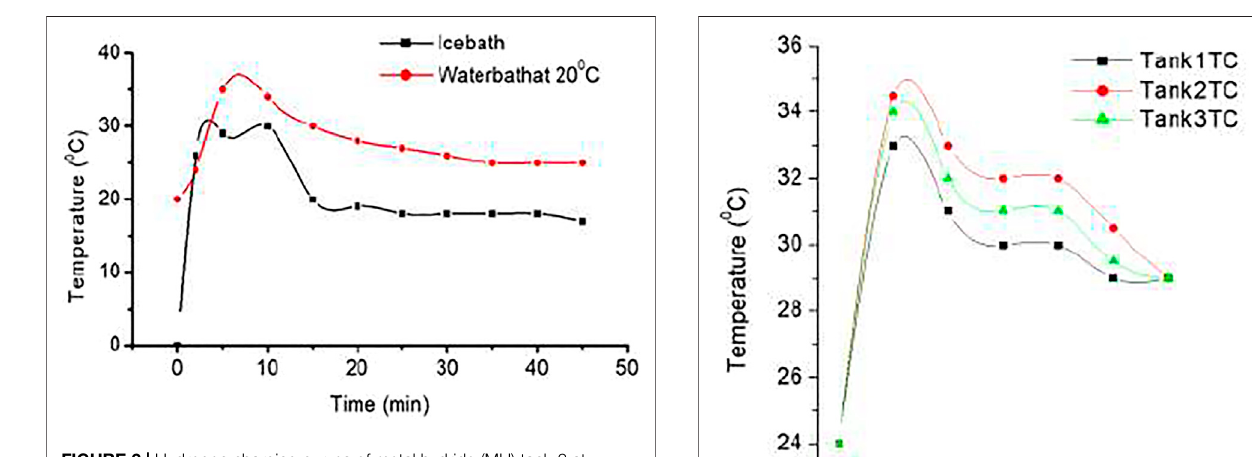
FIGURE 2 | Hydrogen charging curves of metal hydride (MH) tank 2 at 0 ° C (ice bath) and 20 ° C (water bath) at 10 bars.